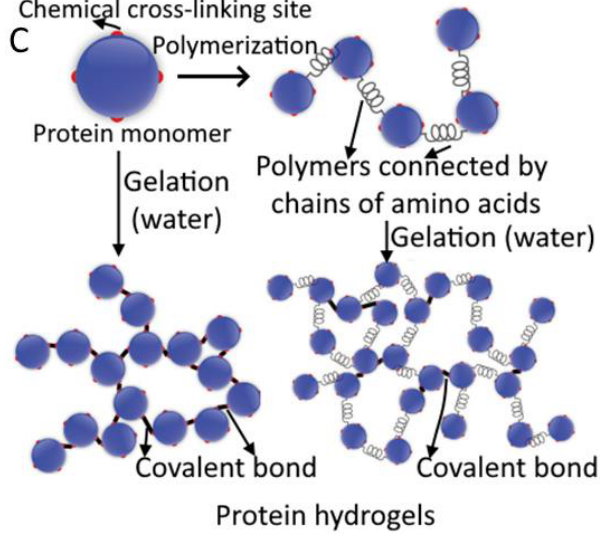
Figure 4. Mechanism of polysaccharide and protein gel formation. Crosslinking of chitosan ( A ); composite hydroxypropyl methyl cellulose-sodium alginate hydrogels ( B ); gelation process of chemically crosslinked protein hydrogels ( C ). ( A , B ) are reprinted with permission from He et al. [89] (Copyright © 2017 Wiley-VCH Verlag GmbH & Co. KGaA, Weinheim, Germany) and Hu et al. [90] (Copyright © 2018 Springer Nature B.V., Dordrecht, the Netherlands), respectively, whereas ( C ) is reprinted from Hanson et al. [91] and is an open-access article (Copyright © 2020 by authors) distributed under the terms and conditions of the Creative Commons Attribution (CC BY) license. HPMC, hydroxypropyl methyl cellulose; CaCl 2 , calcium chloride; CS,